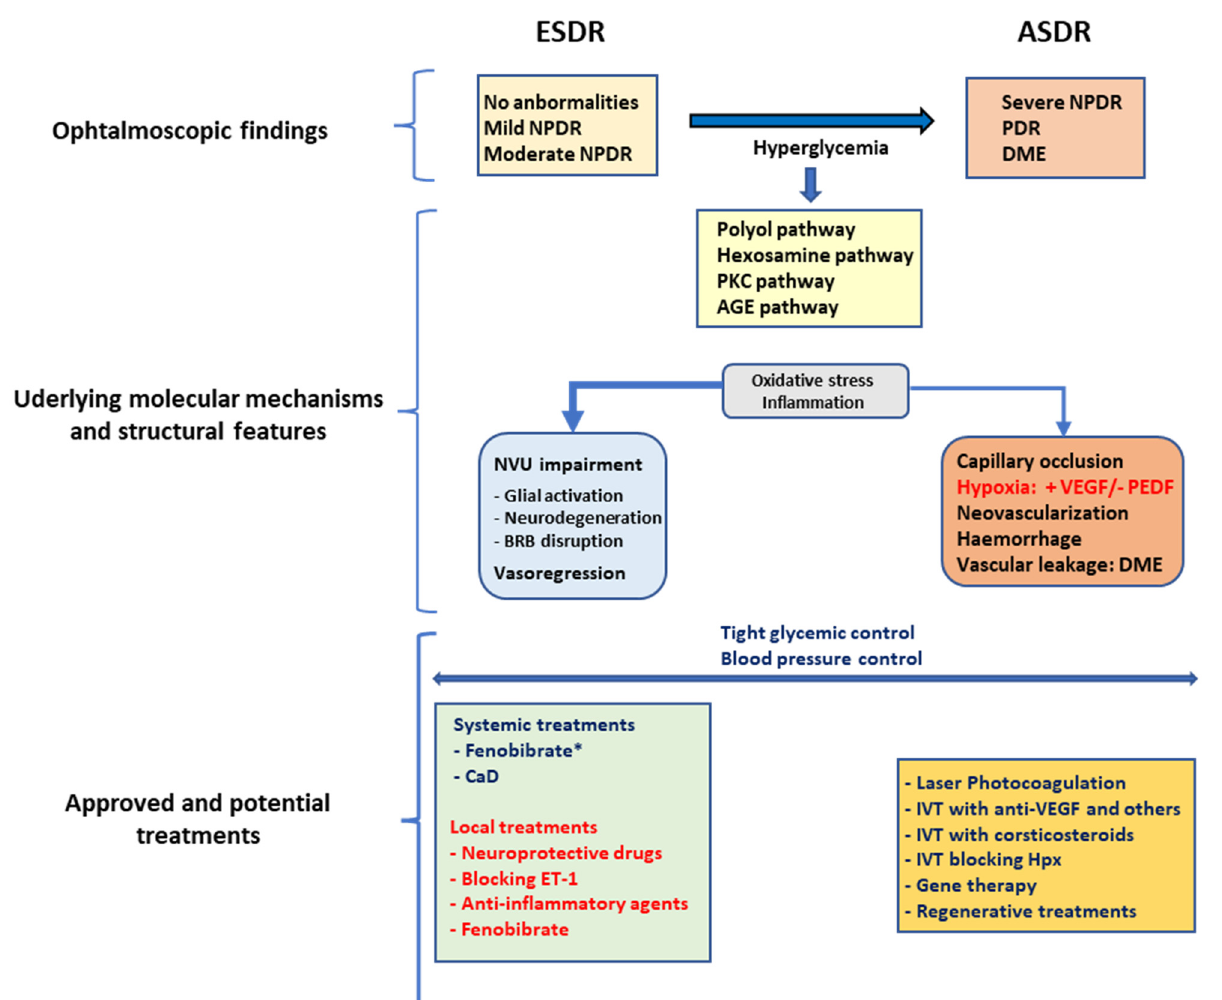
Figure 1. Schematic representation of the main ophthalmologic features of early and advanced stages of DR (ESDR and ASDR) and their main underlying mechanisms and structural features. The approved treatments (blue), and potential treatments (red) that are currently still in the preclinical development or in early clinical development. NVU: Neurovascular unit. IVT: Intravitreal treatment. (*) Fenofibrate has only been approved in few countries.